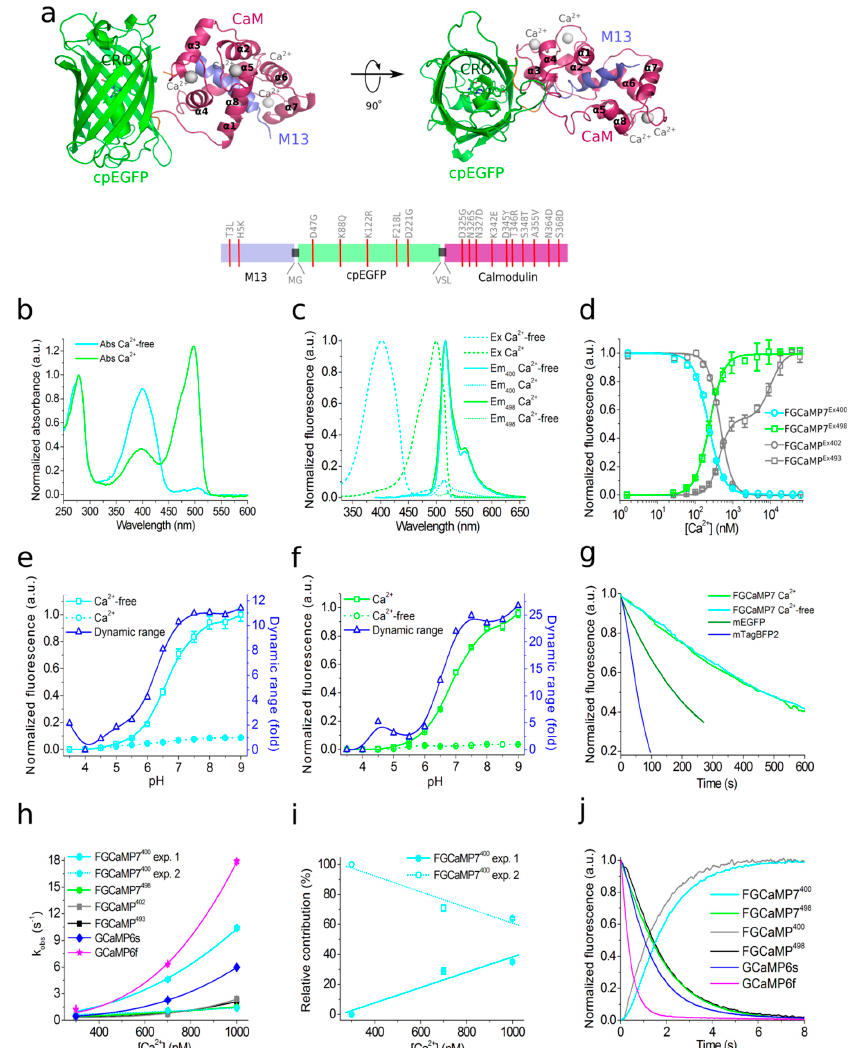
Figure 1. Structure and properties of the FGCaMP7 calcium indicator. ( a , top) Orthogonal views of the structure of the FGCaMP indicator in Ca 2+ -bound state (PDB 6XU4). β -barrel of cpEGFP is shown as a green cylinder, Ca 2+ ions are shown as grey spheres, M13-peptide and CaM are shown in purple and light blue, respectively. α -helices of CaM are indicated. ( a , bottom) Schematic representation of the FGCaMP7 sequence with mutations relative to the original FGCaMP. The numbering follows that for FGCaMP. ( b ) Absorbance spectra in the presence (39 μ M) and the absence of Ca 2+ ions for FGCaMP7. ( c ) Excitation and emission spectra in the presence (39 μ M) and the absence of Ca 2+ ions for FGCaMP7. ( d ) Ca 2+ titration curves for FGCaMP and FGCaMP7. ( e ) Fluorescence of FGCaMP7 as a function of pH at 365 nm excitation. ( f ) Fluorescence of FGCaMP7 as a function of pH at 490 nm excitation. ( g ) Photobleaching curves for FGCaMP7 in the presence (39 μ M) and the absence of Ca 2+